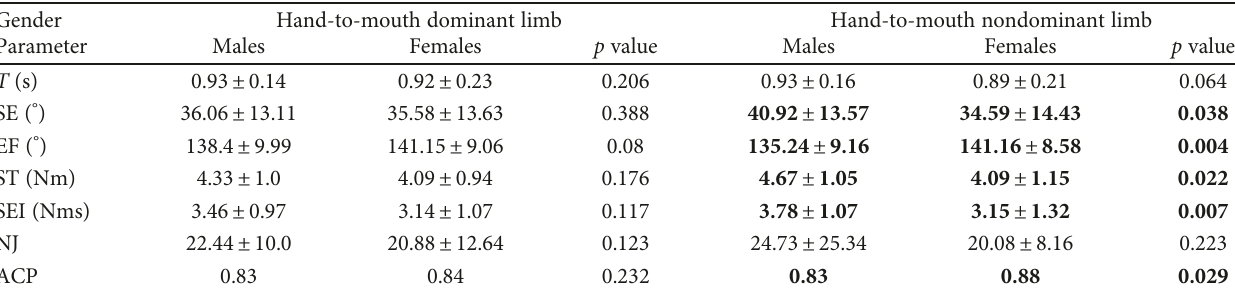
Table 4: Gender subset: hand-to-mouth.